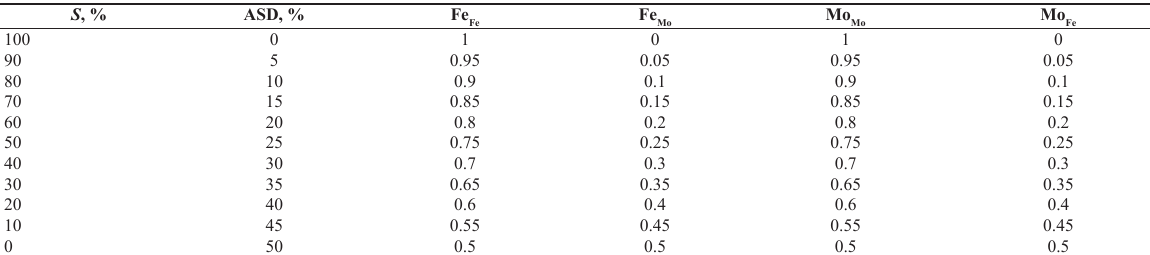
Figure 2. Comparison of the ASD ( 1 – 5 ) calculated as a function of (101) peak intensity ratio with literature data of Rietveld analysis of X-ray diffraction patterns [6], [9], [16], [18], [25–32]: ( 1 ) calculation excluding the (200) peak, ( 2 ) calculation for the sum of (112) and (200) peak intensities, ( 3 ) calculation for the sum of (112) and (200) peak intensities for Sr for the sum of (112) and (200) peak intensities for Sr Table 2. Ion occupation in the SFMO sublattices.